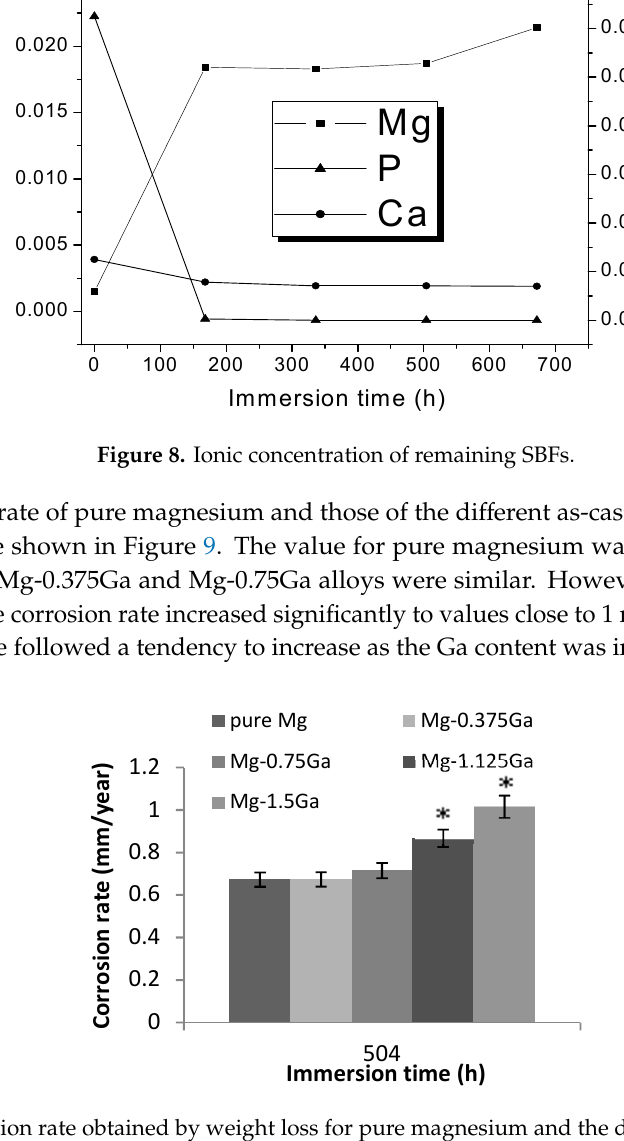
Figure 9. Corrosion rate obtained by weight loss for pure magnesium and the different as-cast alloys after immersion in SBF for 504 h (*Statistically higher than 0.65 mm/year, p > 0.5).